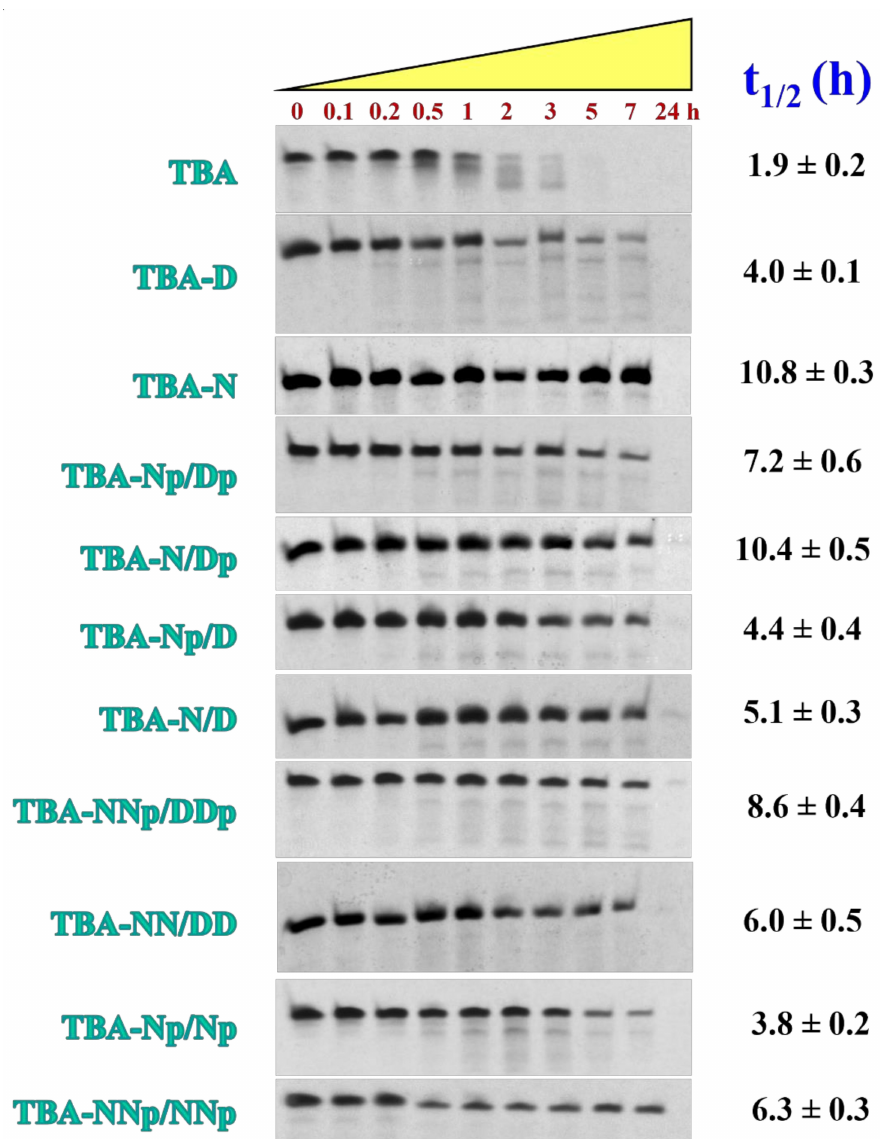
Figure 6. Enzymatic resistance experiments performed on TBA and its derivatives incubated in 80% fetal bovine serum (FBS), as monitored by 20% denaturing polyacrylamide gel electrophoresis for 24 h (time points: 0, 0.1, 0.2, 0.5, 1, 2, 3, 5, 7 and 24 h). For each compound, a representative 20% denaturing PAGE (8 M urea) is reported: samples were loaded at 15 µ M, and the gels were run at 200 V constantly, at r.t., for 2.5 h in TBE 1X (running buffer). The intensity of each oligonucleotide band on the gel is also expressed as a percentage of the remaining intact aptamer (see Figure S14) with respect to the untreated oligonucleotide, and the values were fitted with an equation for first order kinetics, allowing the calculation of the half-life in serum of each aptamer (t 1/2